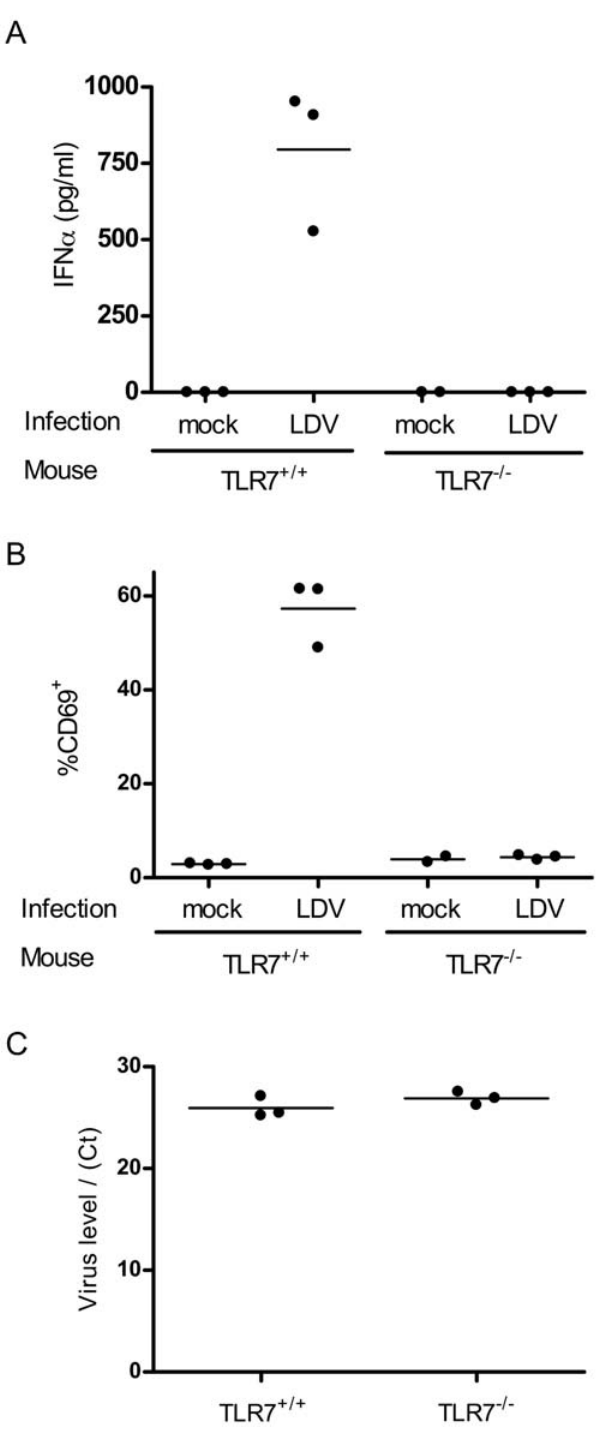
Figure 4. LDV-induced CD69 upregulation is TLR7-dependent. TLR7 wild type and knockout mice on the 129SvEv genetic background were infected with LDV and blood was analyzed at 16hpi. (A) IFN a levels in plasma were significantly reduced in TLR7 2 / 2 mice as measured by ELISA (PBL Interferon Source). Values in TLR7 + / + mice averaged 795.5 pg/ml while only trace amounts of IFN a were detected in TLR7 2 / 2 mice ( TLR7 + / + vs. TLR7 2 / 2 p=0.0041 by T test). (B) The low levels of IFN a in TLR7 2 / 2 mice correlated with reduced percentages of lymphocytes expressing CD69 (TLR7 + / + 57.30% + / 2 4.15% CD69 + vs. TLR7 2 / 2 4.37% + / 2 0.28% CD69 + , n=3, p=0.0002 by t test). (C) LDV-